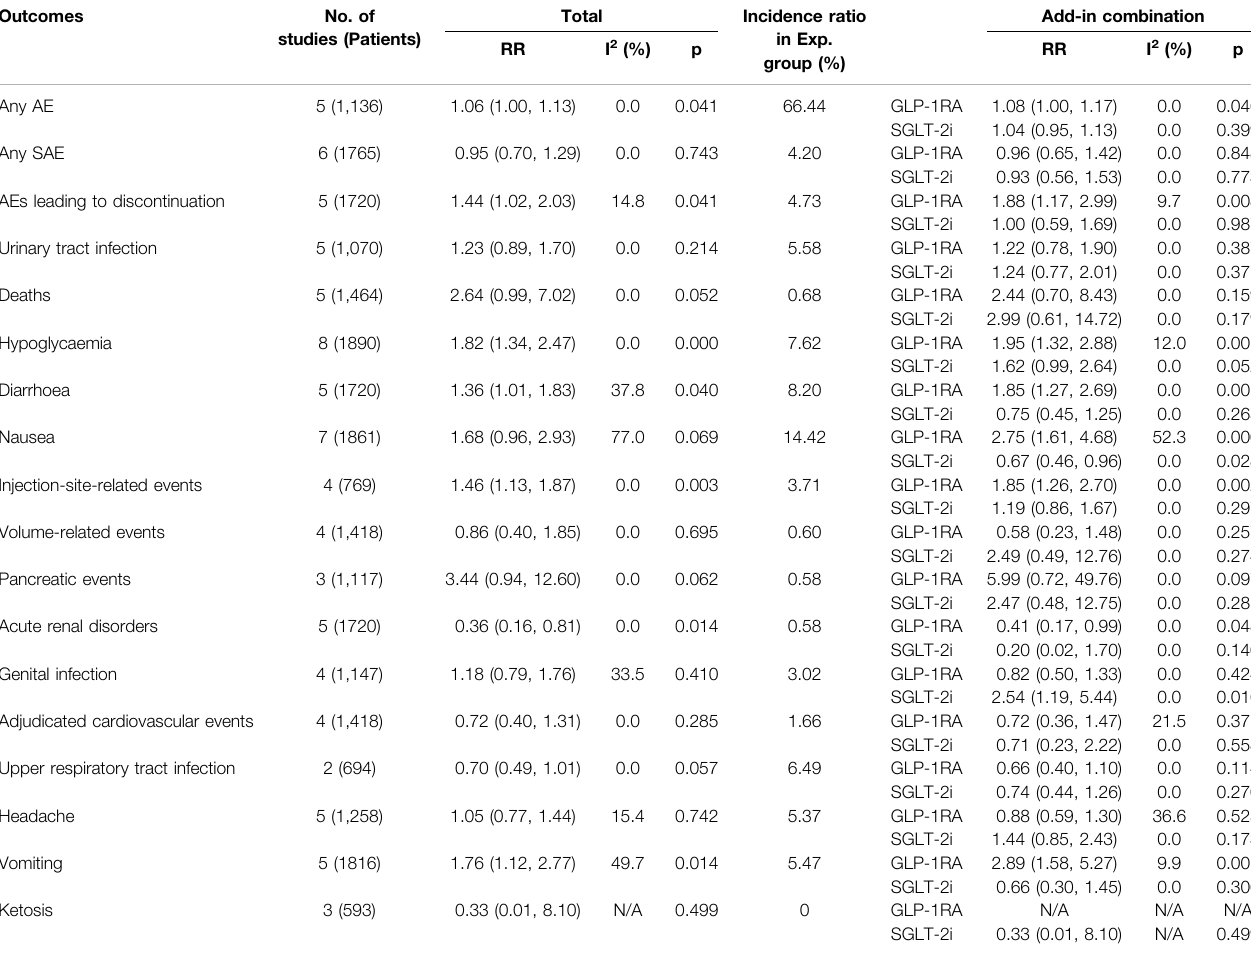
TABLE 3 | Total results and subgroup results for all safety measures that considered of the included studies. Exp: experimental. Outcomes No. of Total Incidence ratio Add-in combination studies (Patients) in Exp. RR RR group (%) Any